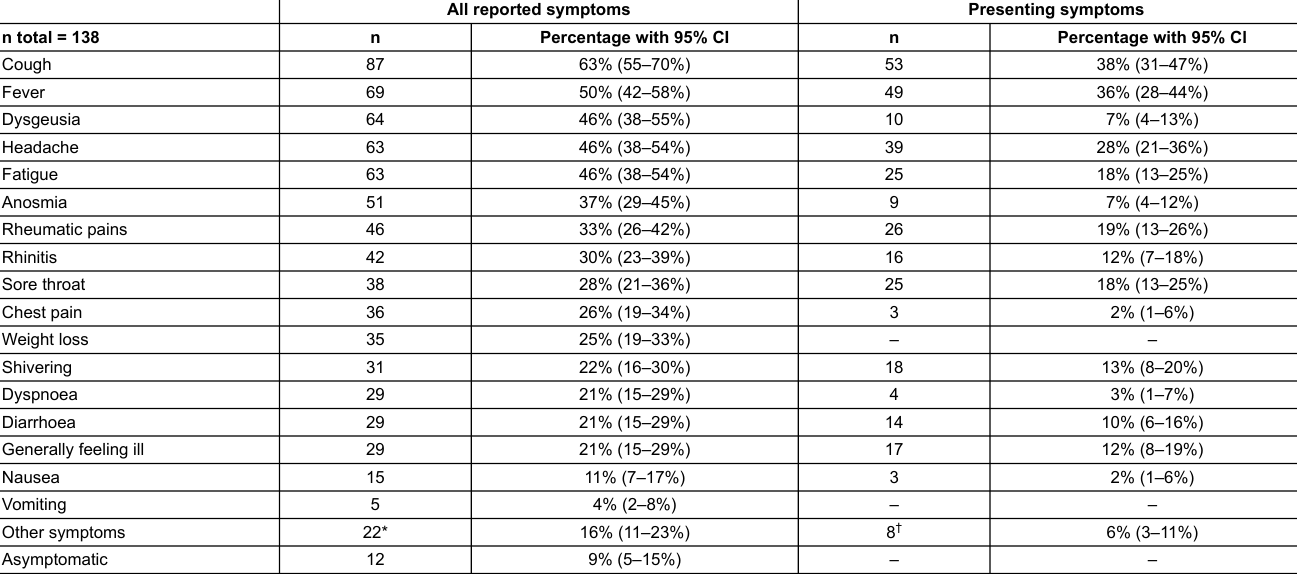
Table 3: Symptoms reported by RT-PCR- or antibody-positive cases. This table summarises the symptoms patients experienced during the course of their COVID-19 infections as well as the initial presenting symptoms (symptoms experienced on the first day of symptomatic disease). All reported symptoms Presenting